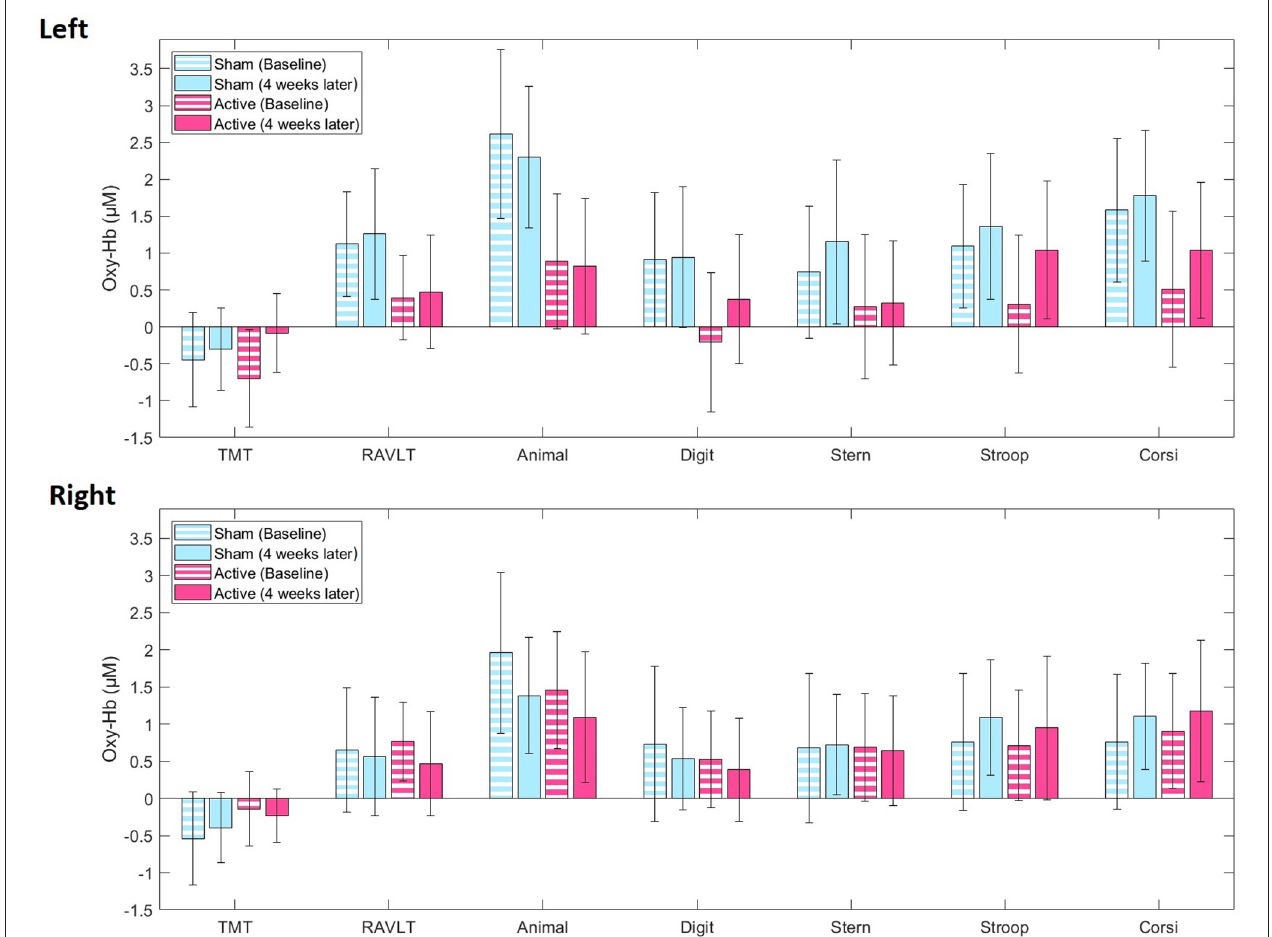
FIGURE 2 | Averaged blood oxygenation (oxy-Hb) and confidence intervals in the active (pink) and sham (blue) iTBS group during the cognitive test battery at baseline (stripes) and 4 weeks later (full color) in the left and right fNIRS channel. TMT, Trail-Making-Test; RAVLT, Rey Auditory Verbal Learning Test; Animal, Animal Naming Test; Digit, Digit Symbol Coding Test; Stern, Sternberg Memory Test; Stroop, Emotional Stroop Test; Corsi, Corsi Block Tapping